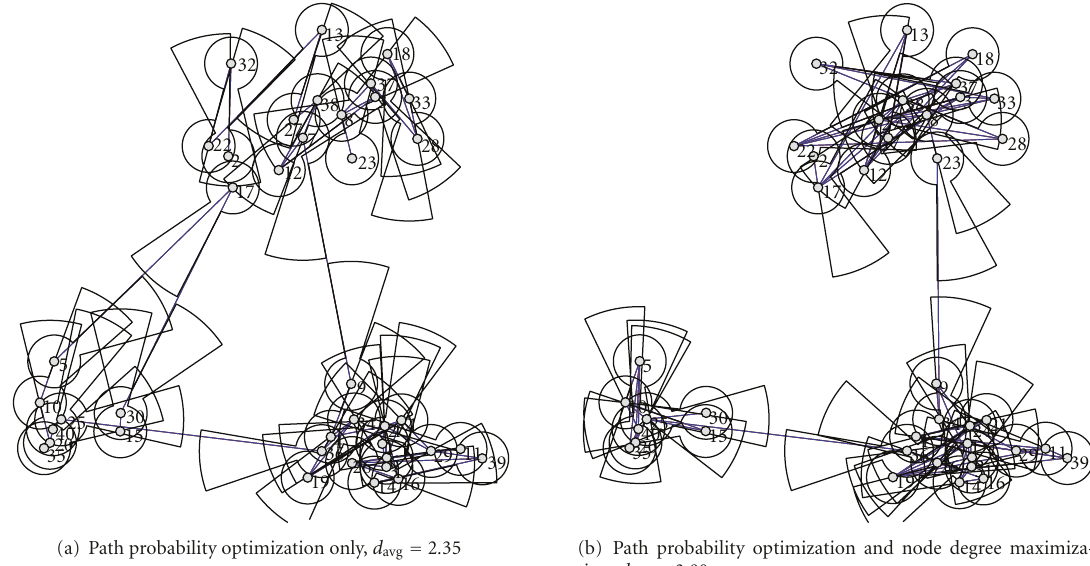
(b) Path probability optimization and node degree maximiza- tion, d avg = 3 . 80 Figure 4: 40-node example network.